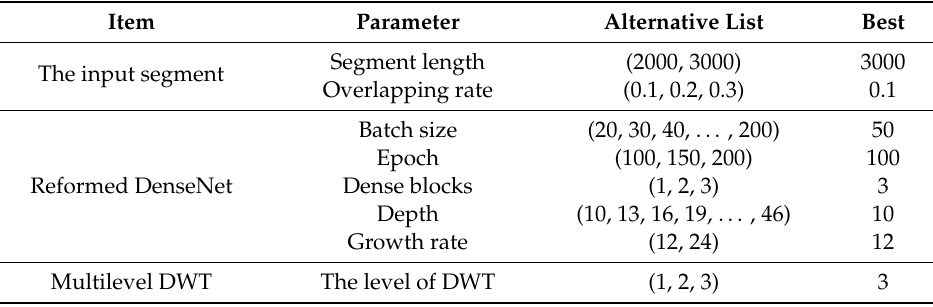
Table 8. Grid parameter list and the optimal parameters of MDD-Net.